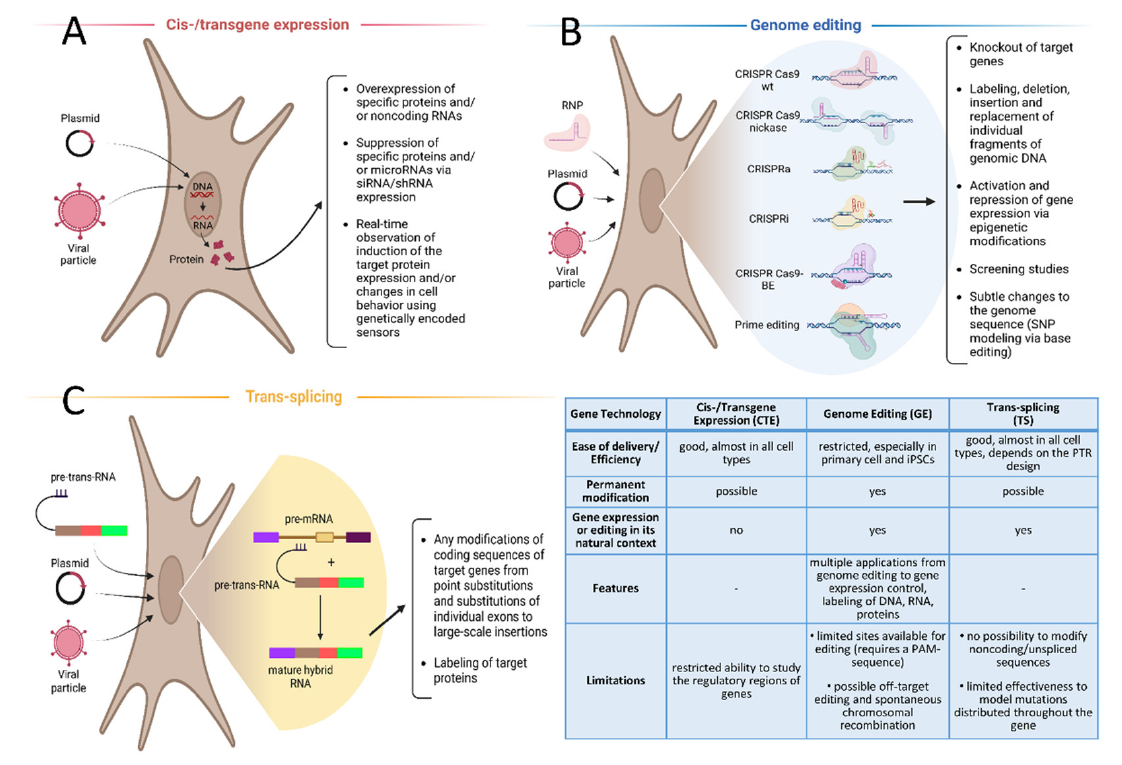
Figure 2. Main genetic engineering technologies for cell-based modelling: principle, advantages, limitations, and potential applications: ( A )—cis-/transgene expression, ( B )—genome editing, ( C )—trans-splicing. Created with BioRender.com.